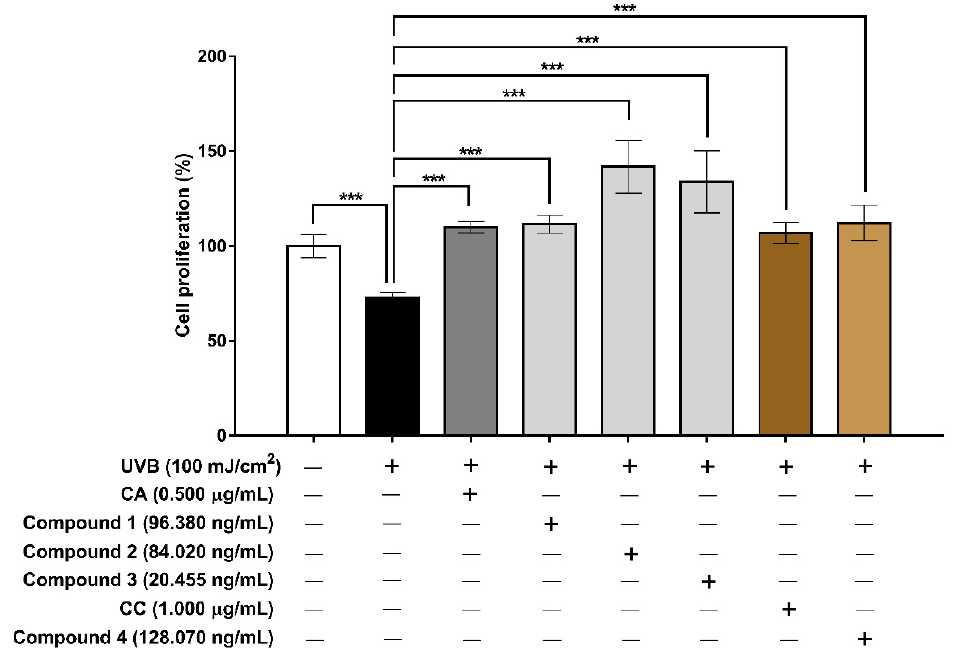
Figure 7. Effects of the CA and CC extracts and isolated constituents on cell proliferation by UVB- induction. Human skin keratinocytes were pre-treated with the tested samples for 24 h before repeated UVB irradiation (100 mJ/cm 2 × 10 times). Cells were harvested for 24 h after the tenth of UVB irradiation. The percentage of cell proliferation was determined via the trypan blue assay. Data are presented as the means ± SD. *** p < 0.05, using unpaired Student’s t -test.